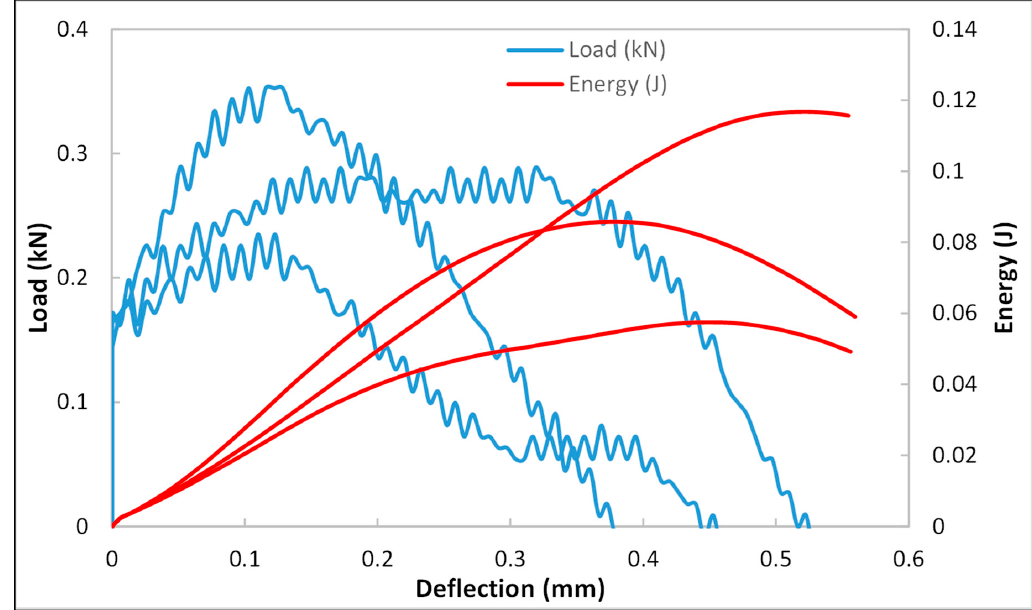
Figure 9. Load and deflection plot of brine-saturated cement mortar samples. Table 2. Impact test results of dry specimens.